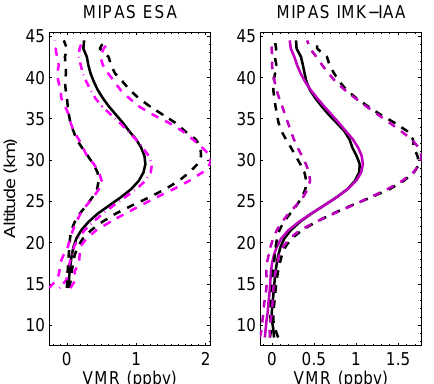
Figure 13. Mean morning N 2 O 5 profiles (in ppbv) for coincident diurnally scaled ACE-FTS (black) and MIPAS (coloured) measure- ments and corresponding measurement standard deviations (dashed lines). Coincidence criteria for all comparisons are within 3h and